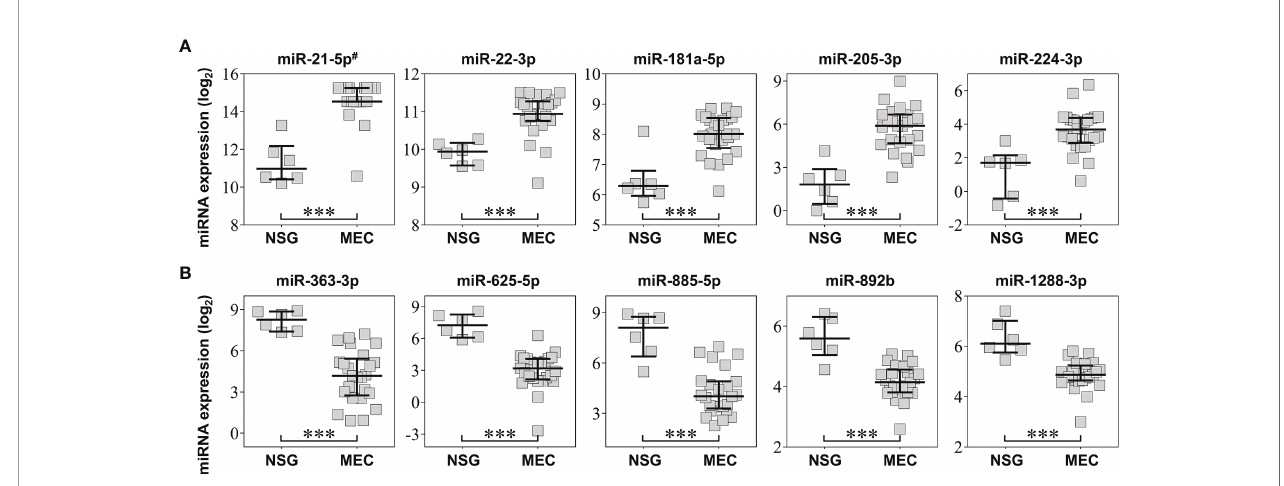
FIGURE 2 | Top fi ve most signi fi cant overexpressed (A) and underexpressed (B) miRNAs obtained in the microarray analysis. The error bars and middle line represent the interquartile range and median, respectively. NSG: surrounding normal salivary gland tissues; MEC: mucoepidermoid carcinoma tissues. # miR-21-3p was omitted (both mature sequence from miR-21 precursor were highly signi fi cant). ***P < 0.001 (t